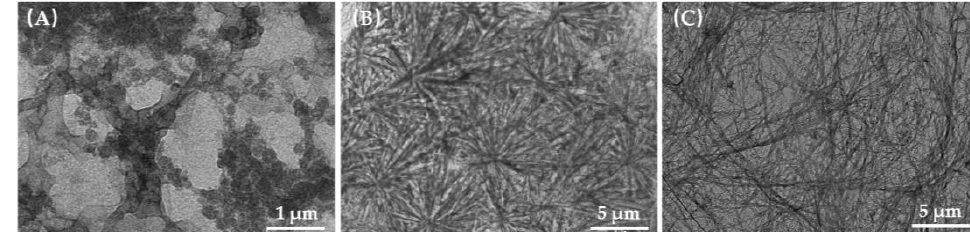
Figure 11. TEM images of self-assembled aggregates in water for 2C8-Lys-Na ( A ) , 2C10-Lys-Na ( B ), and dried hydrogel formed by 2C12-Lys-Na ( C ).